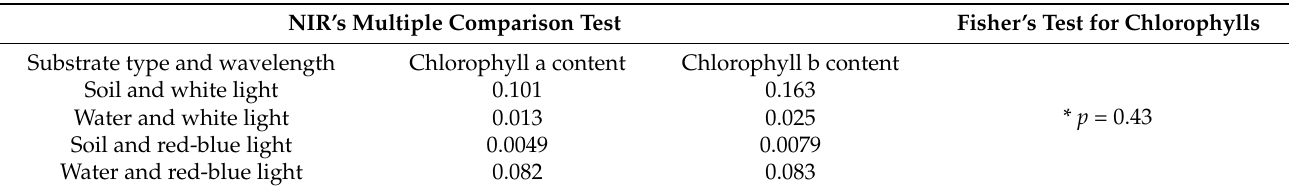
Table 6. Summary of statistical analysis of relationships between chlorophyll a and b ratios, substrate types (soil vs. water) and supplementary light treatments (white vs. red-blue). * p —probability value. * Significant differences ( α = 0.05), values greater than the selected significance level are not